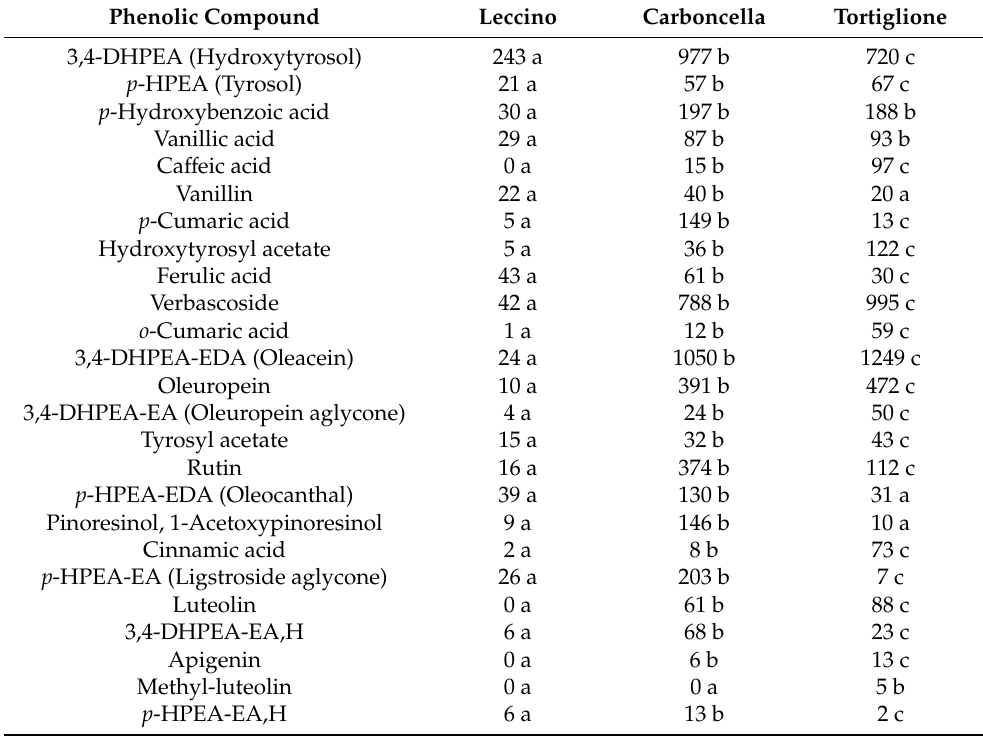
Table 2. Amount of individual identified phenolic compounds in DMF fresh p â t é . Data are expressed in mg / kg of p â t é . Significant di ff erences are indicated by di ff erent letters at p < 0.05 ( t -test). Phenolic Compound